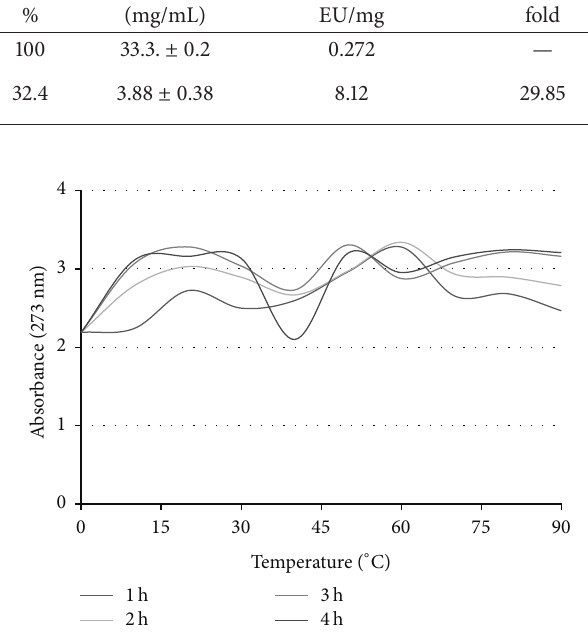
Figure 2: The effect of temperature on the synthesis of silver nanoparticles using peroxidase enzyme from Euphorbia ( Euphorbia amygdaloides